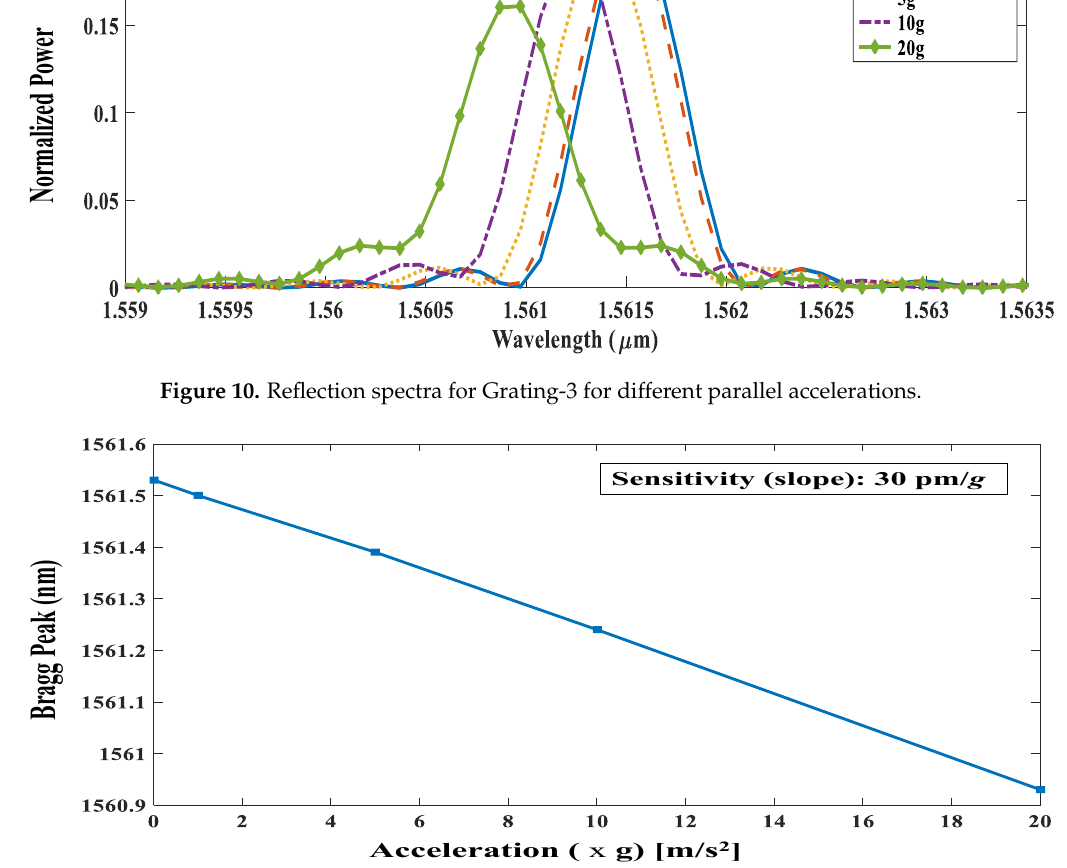
Figure 11. Variation of Bragg peak with applied parallel acceleration causing compression of